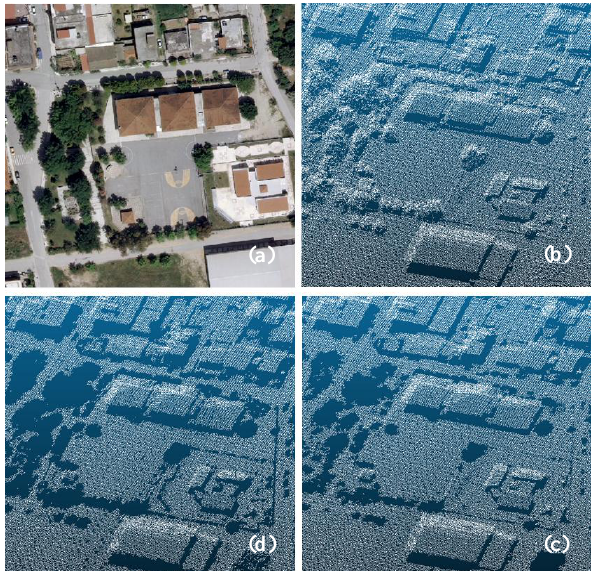
Figure 3. Removal of the vegetation of the LIDAR point clouds; (a) the orthoimage (b) the raw LIDAR point cloud, (c) the cleared LIDAR point cloud by the bilateral filtering, and (d) the cleared LIDAR point cloud by the scan line smooth